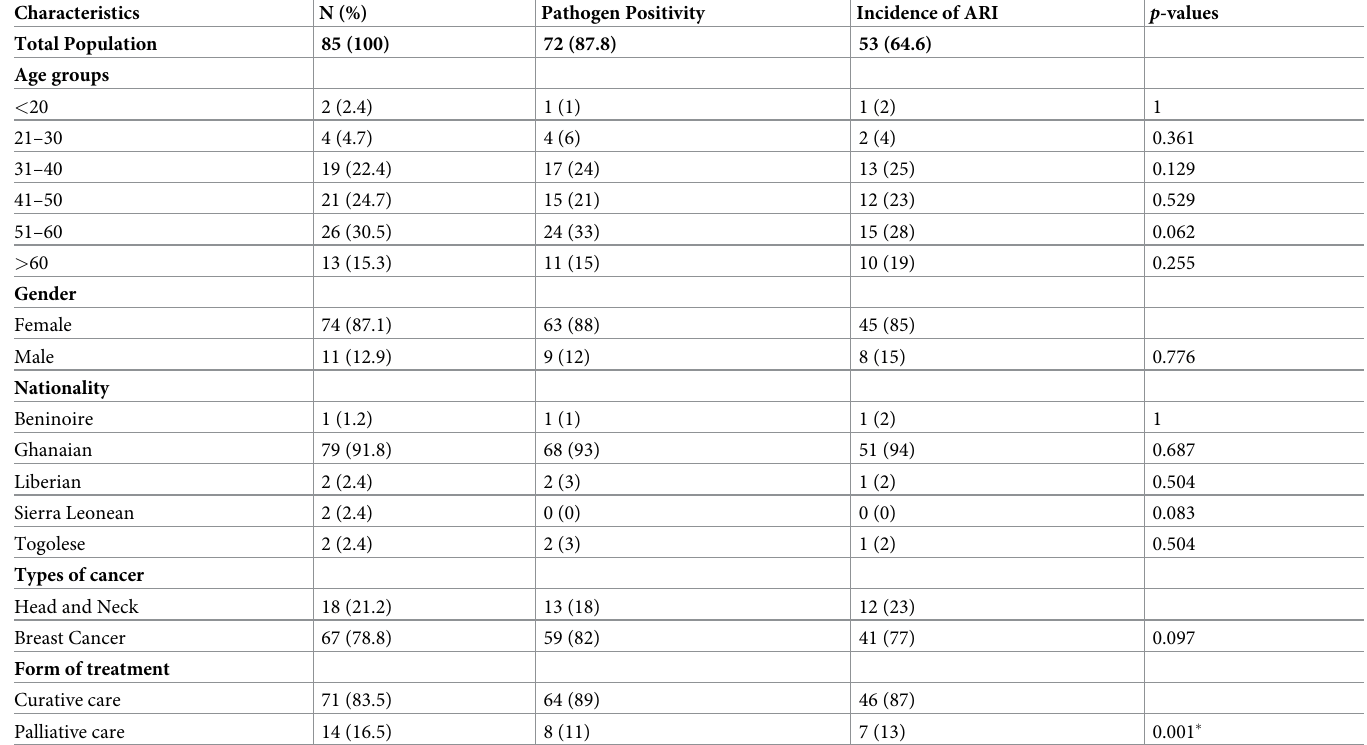
Table 2. Demographics and clinical characteristics of study participant.